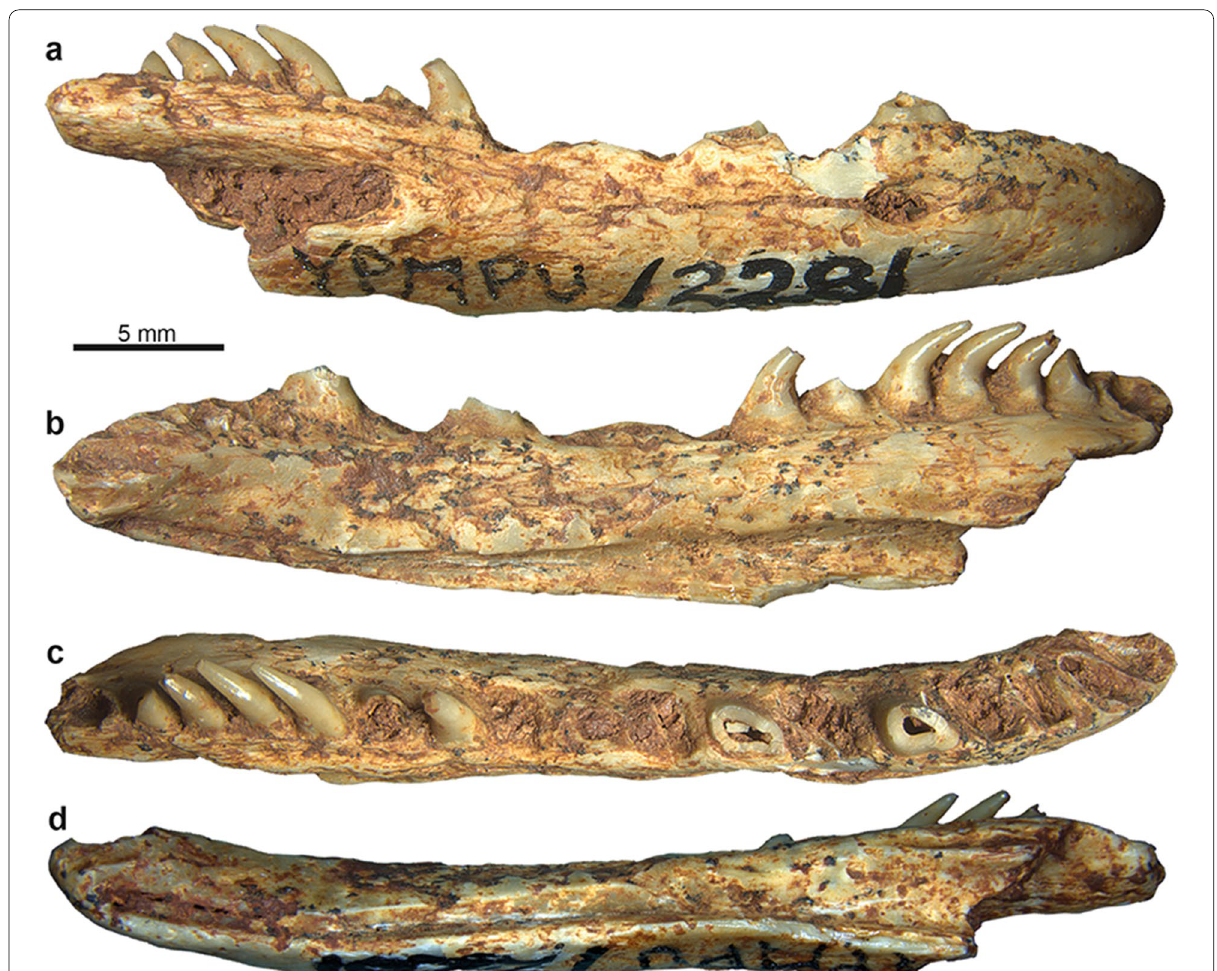
Fig. 98 Phosphoroboa filholii comb. nov. from an imprecisely known locality near Mouillac, Phosphorites du Quercy: right dentary (YPM-VPPU 30397) in labial ( a ), medial ( b ), dorsal ( c ), and ventral ( d )